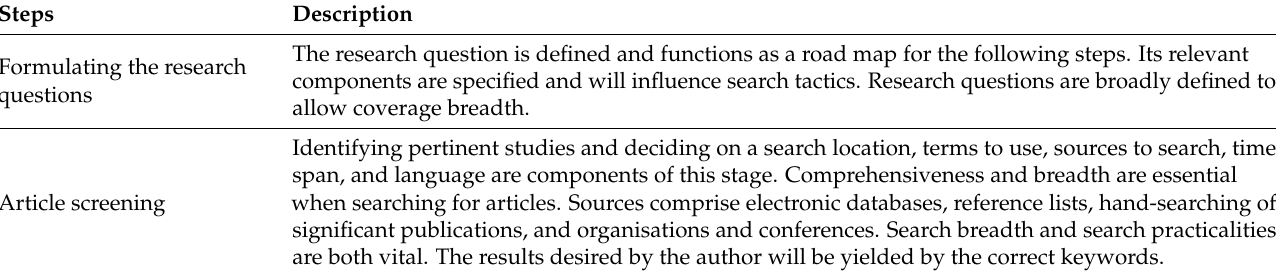
Table 1. Thematic review methodology steps